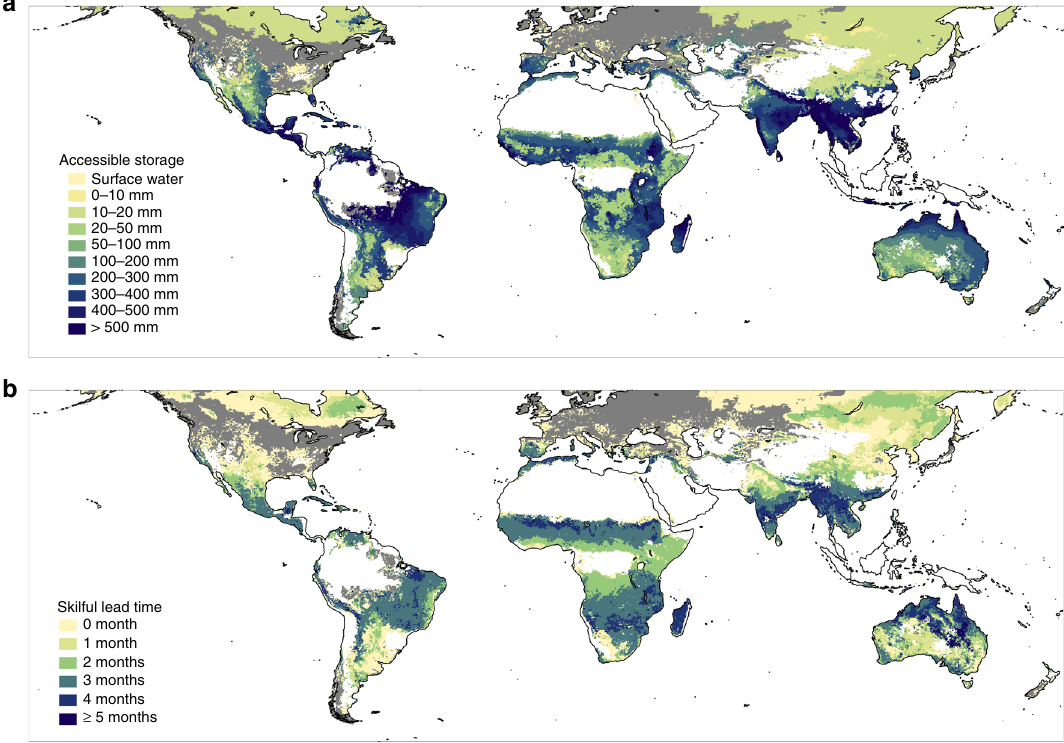
Fig. 2 Maximum accessible storage capacity and skilful forecast lead time. a Accessible storage here relates to the soil depth to which vegetation Normalised Difference Vegetation Index (NDVI) responds most strongly. b Lead time for skilful vegetation condition forecasts. Lead time is counted from current month (0) to over 5 months. The 0-month lead time implies that skilful greenness predictions can only be made for the current month. Unvegetated and wet regions were masked out in white as Fig. 1a. The areas where vegetation are less responsive to water are shaded in